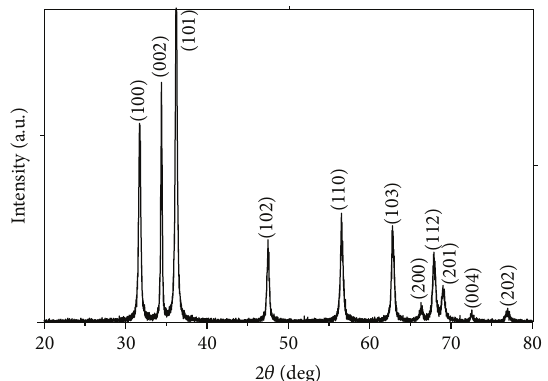
Figure 2: A representative XRD pattern of as-prepared ZnO nano-